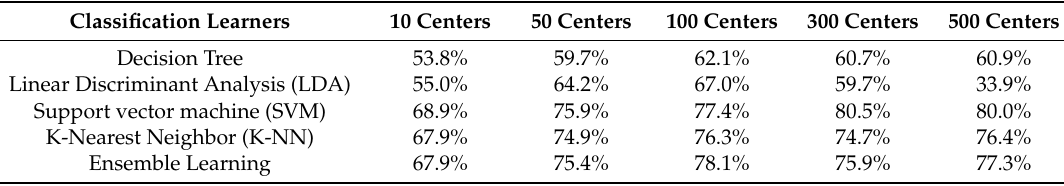
Table 3. Accuracy of BOW based on different machine-learning classifiers.